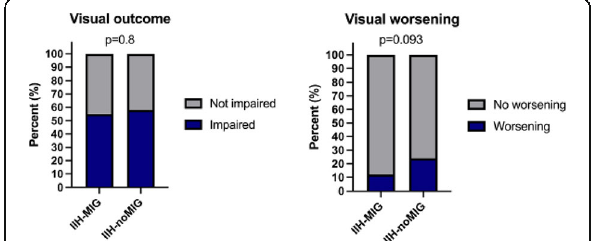
Fig. 1 (abstract P217). See text for